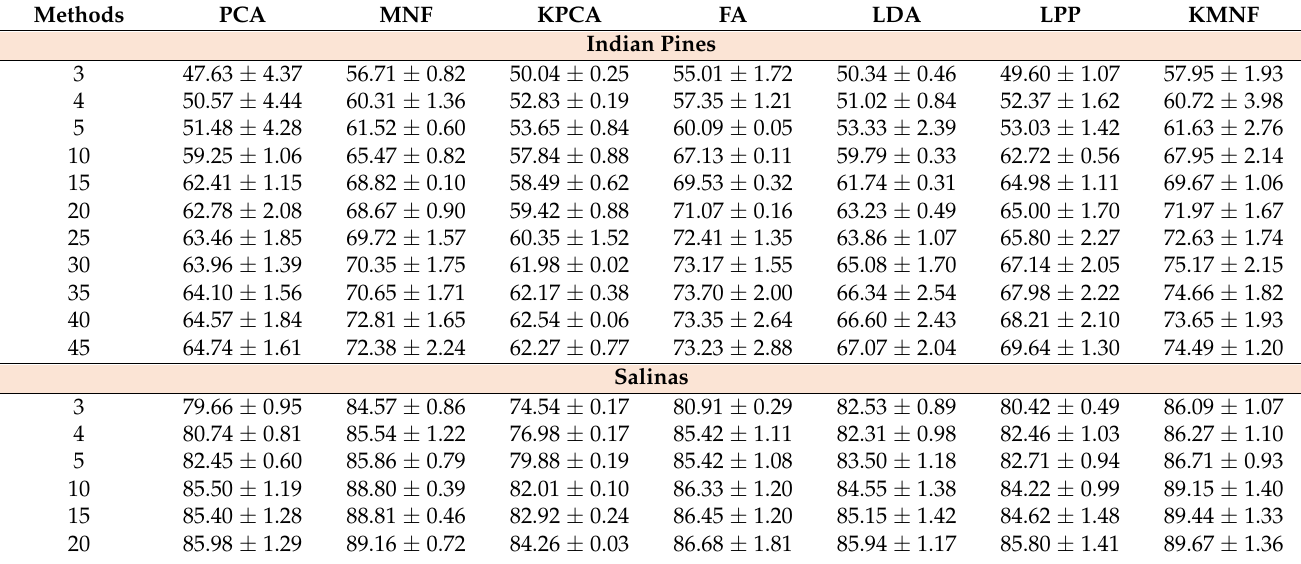
Table 4. The overall accuracies and confidence intervals of SVM classifier after each feature extraction